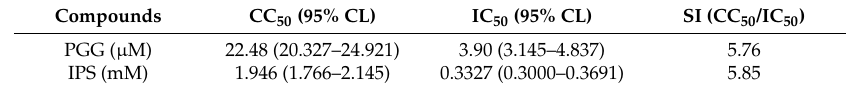
Table 1. Cytoxicity, anti-RABV effect, and selectivity indices of tested compounds.